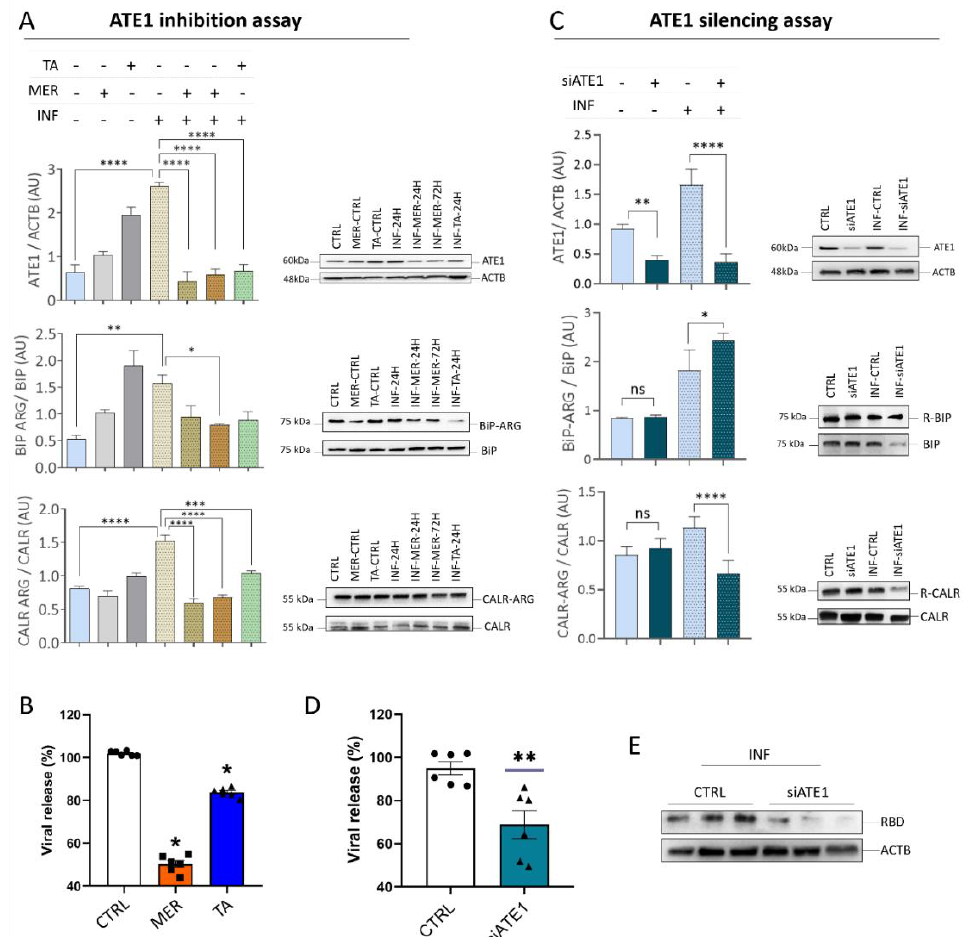
Figure 7. ATE1 inhibition and silencing assay in Calu-3 infected cells. ( A ) Representative images of the Western blot analysis performed on cells exposed to the inhibitors merbromin (MER, 25 µ M) and tannic acid (TA, 1 µ M) for ATE1/ACTB, R-BiP/BiP, R-CALR/CALR, and R-PDI/PDI proteins; ( B ) PCR results for viral release after exposure to the inhibitors; ( C ) representative images of the Western blot analysis performed on Calu-3 cells silenced for ATE1 . The proteins ATE1/ACTB, R-BiP/BiP, and R-CALR/CALR were evaluated; ( D ) PCR results for viral release after ATE1 silencing; ( E ) Western blotting of infected Calu-3 cells for INF-CTRL and INF-siATE1 groups using anti-RBD antibody. Each point represents an independent experiment ( n = 3). The level of significance indicates: **** p <0.0001; *** p < 0.001; ** p < 0.005; * p < 0.05. ns indicates no